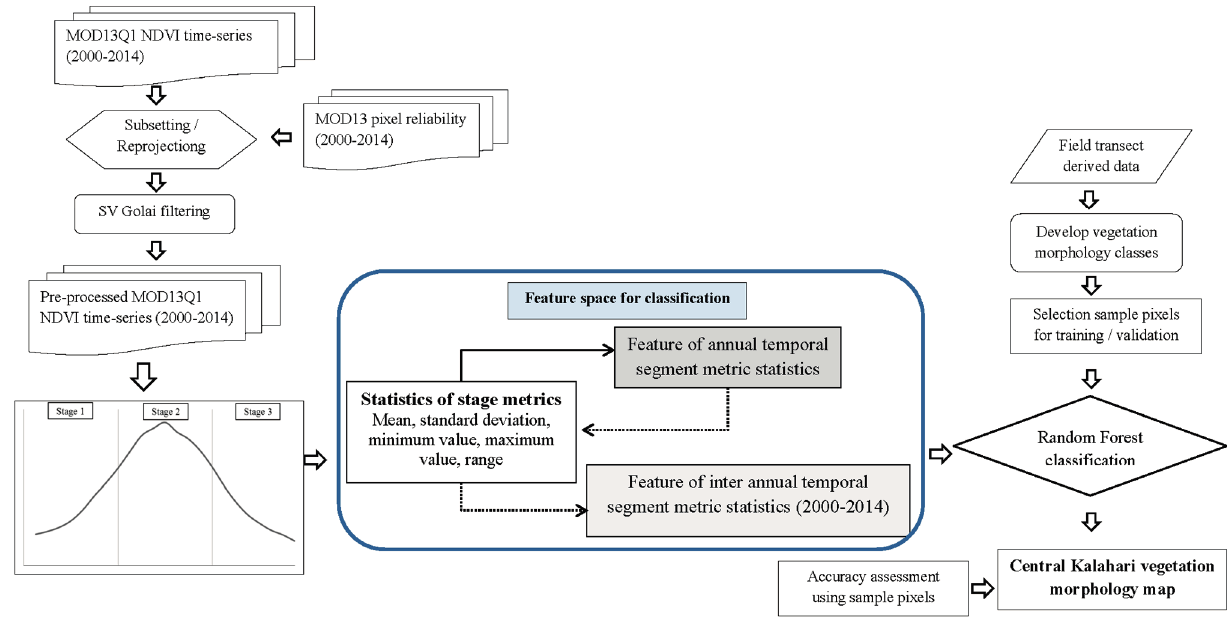
Figure 3. Flowchart illustrating the methodology followed for mapping vegetation morphology types by combining field data with MODIS time-series derived